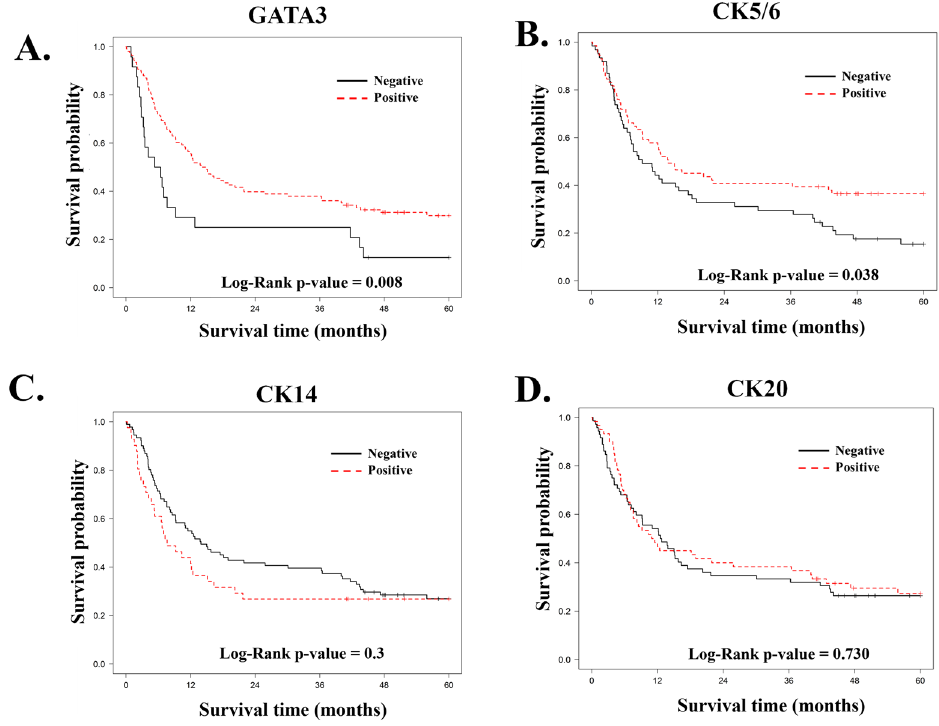
Figure 2. ( A – D ) Kaplan–Meier curves demonstrate the survival probability in 132 patients with MIBC according to marker expression by IHC; GATA3 ( A ), CK5/6 ( B ), CK14 ( C ), and CK20 ( D ).